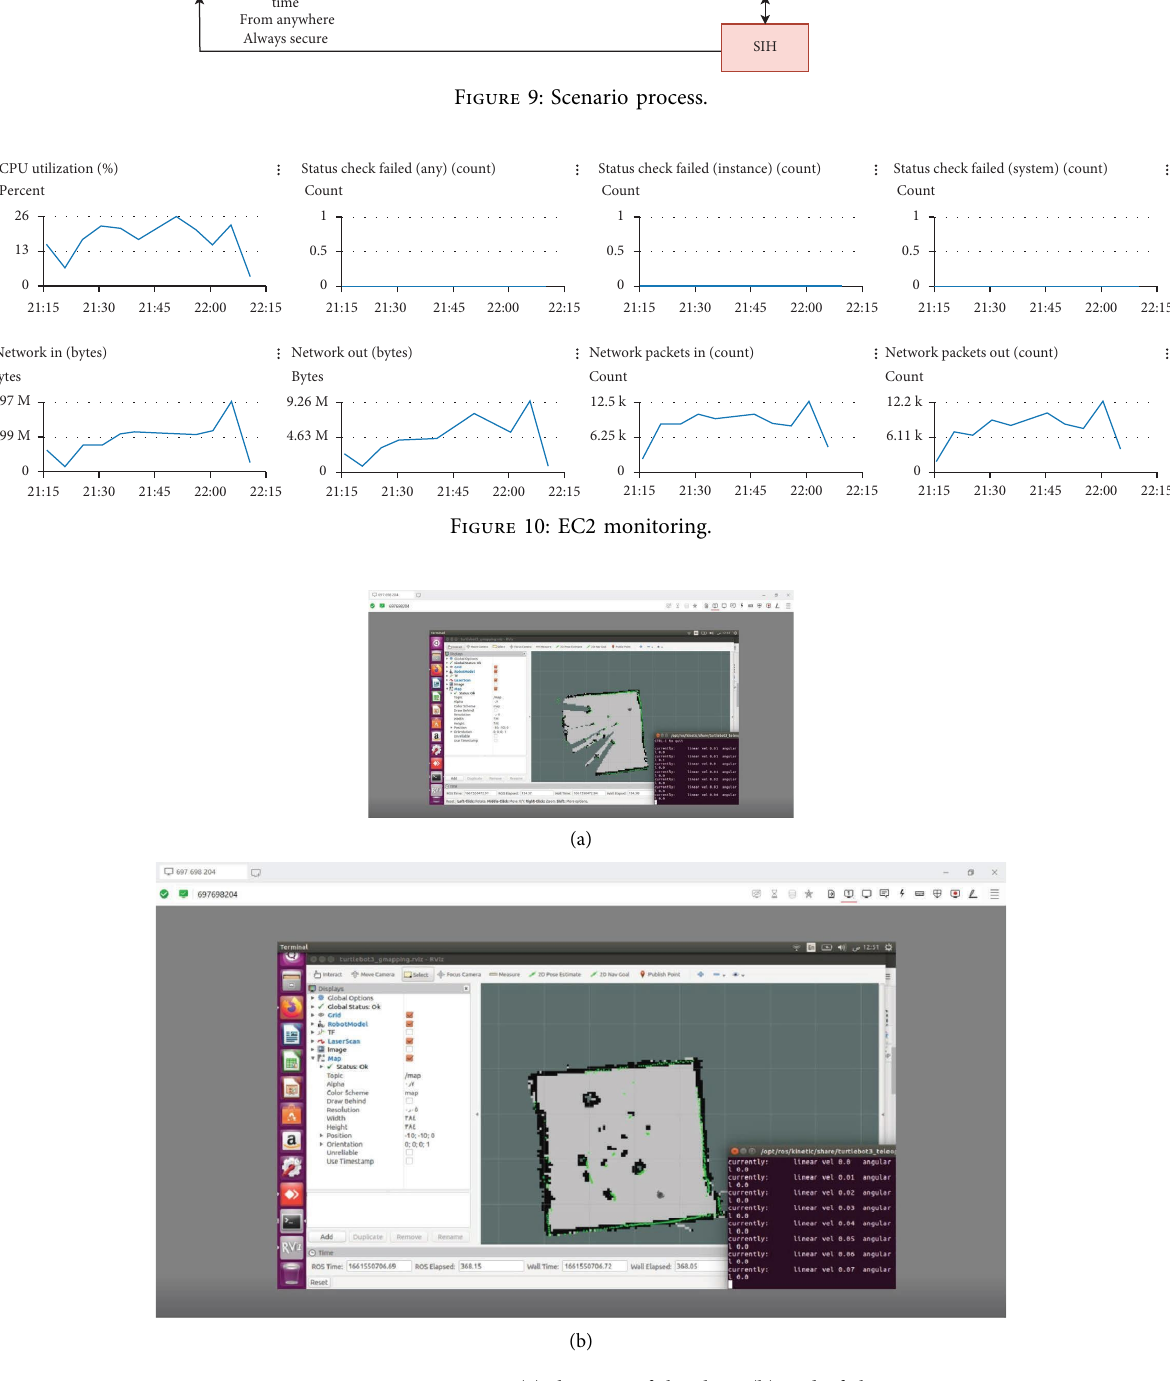
Figure 11: Via AWS EC2: (a) the start of the slam; (b) end of